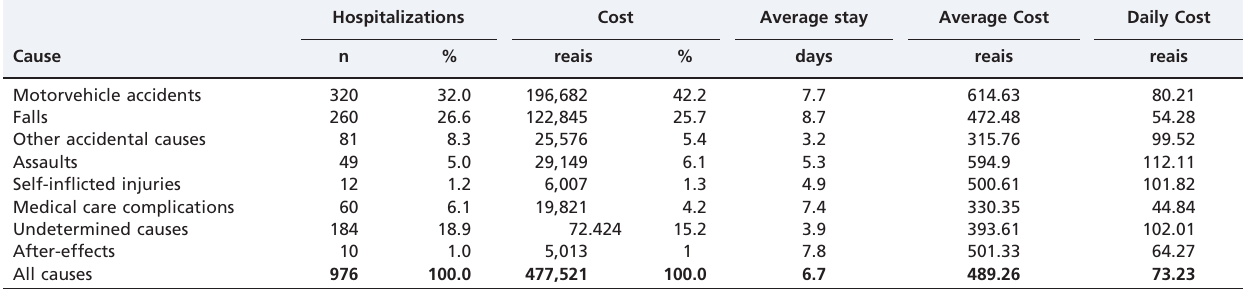
Table 4 - Admissions due to external causes, total amount, average length of stay, average cost, and daily cost, according to the type of cause. City Hospital of Sa˜o Jose´ dos Campos, Sa˜o Paulo, Brazil, in the first half of 2003.